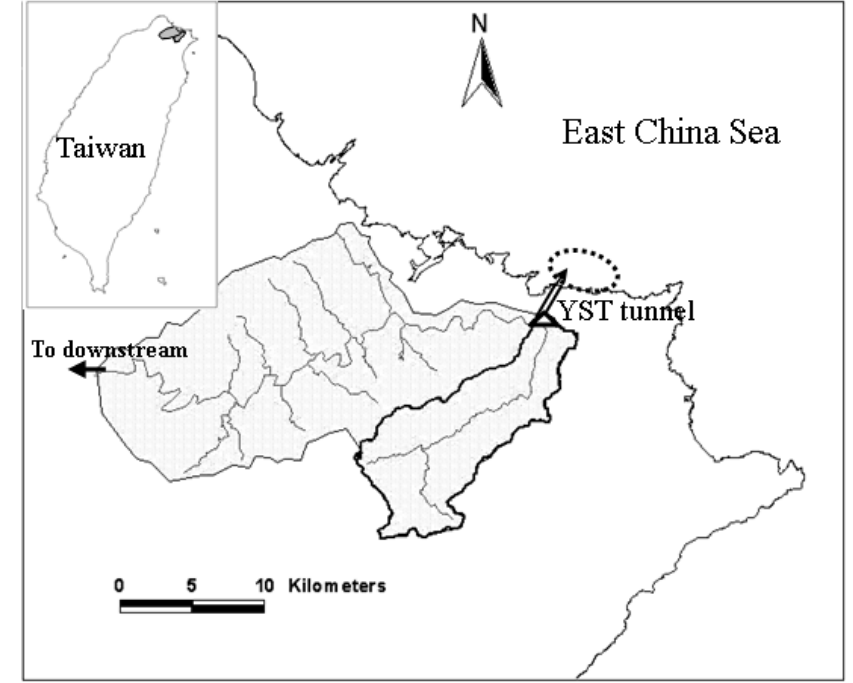
Figure 1. Location map of the study area. Dashed circle indicates the coastal area where water sampling was conducted. Shaded area shows the Keelung River